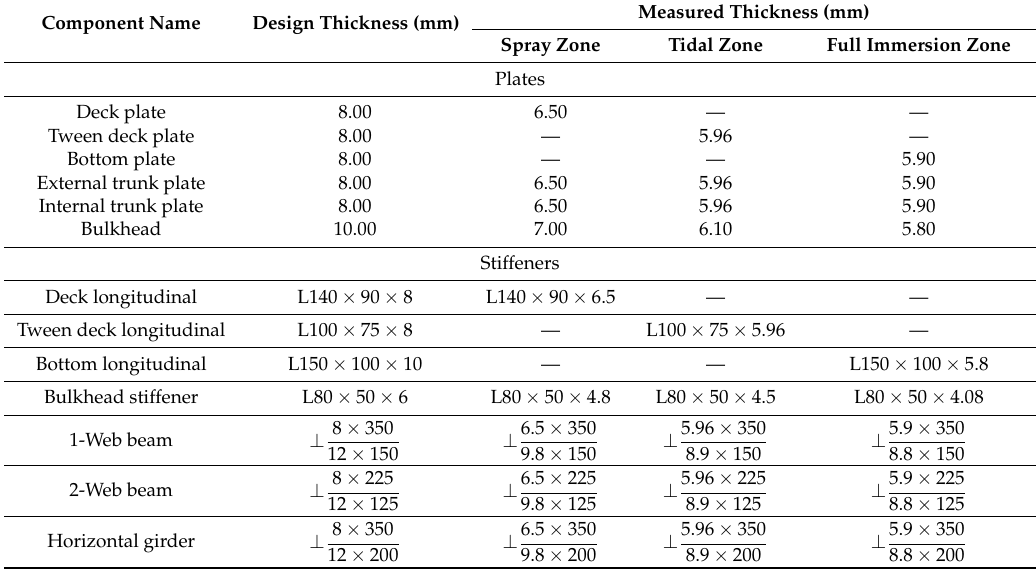
Table 5. Average 5-year predicted residual thickness of typical plates and stiffeners in the protective